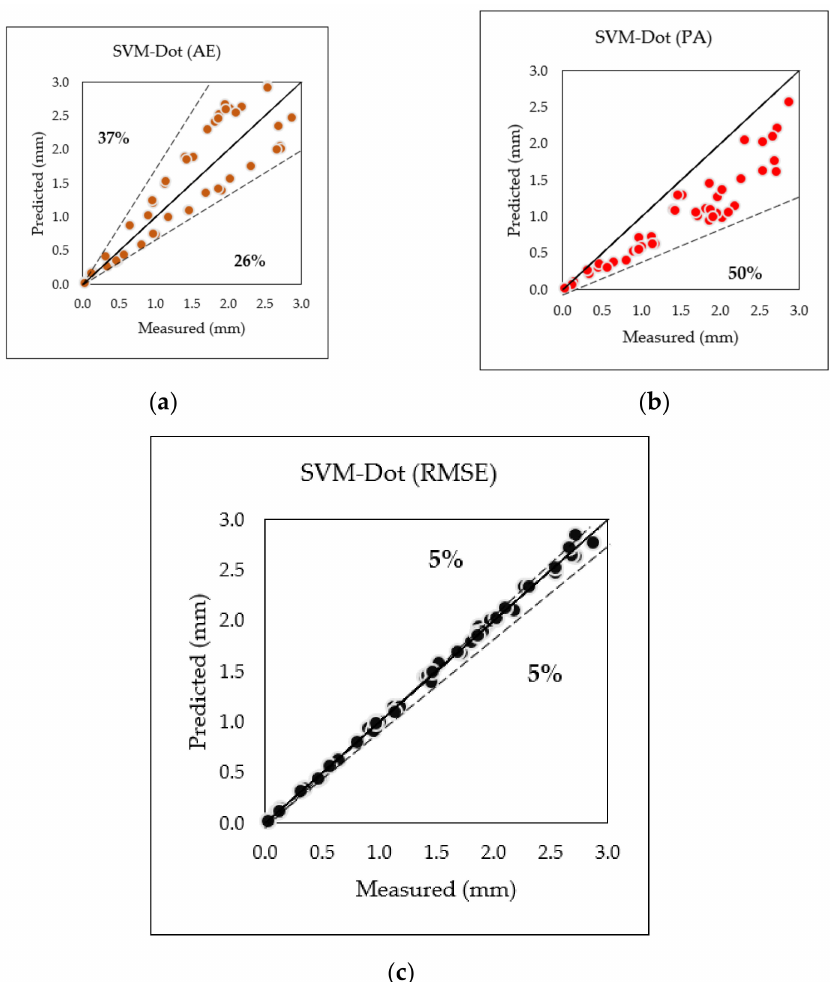
Figure 13. The distribution of predicted crack width for: ( a ) Absolute error (AE), ( b ) prediction average (AE), and ( c ) root mean square error